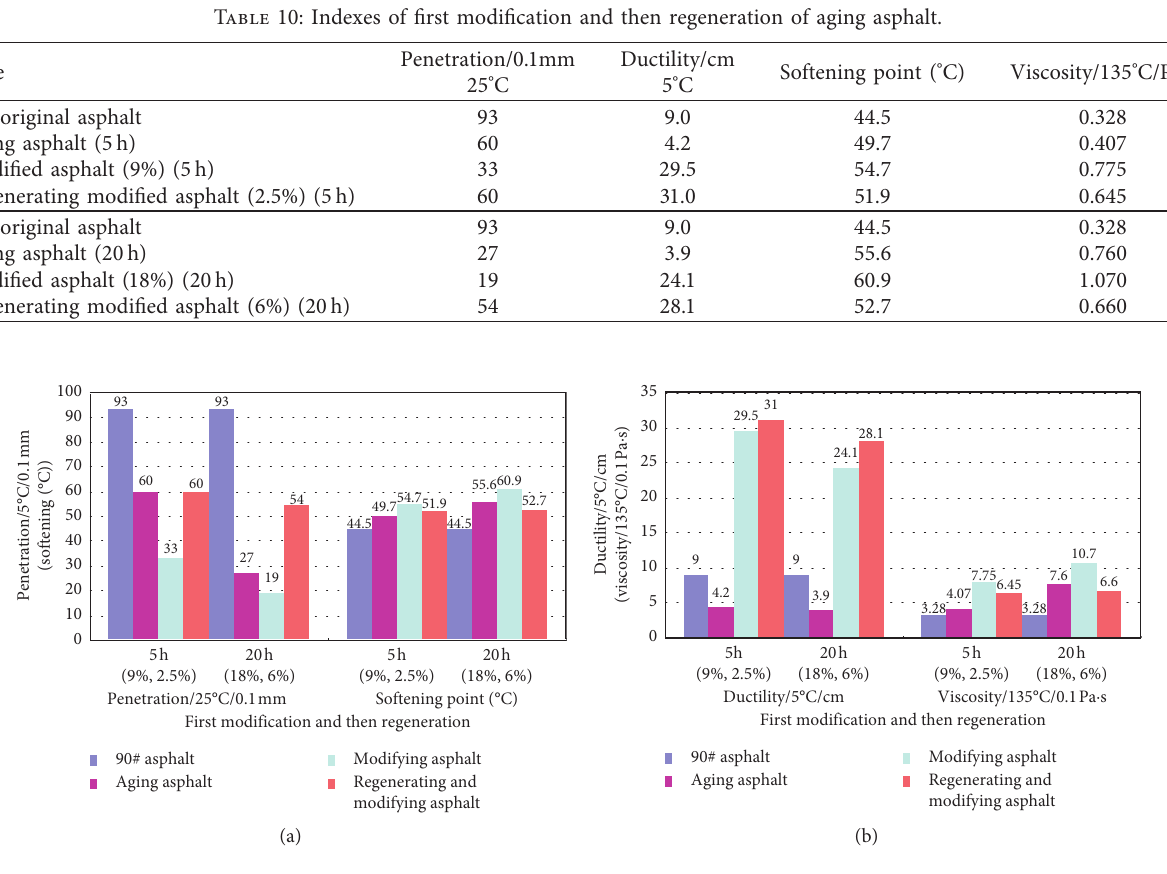
Figure 7: Index relationships of first modification and then regeneration of aging asphalt.